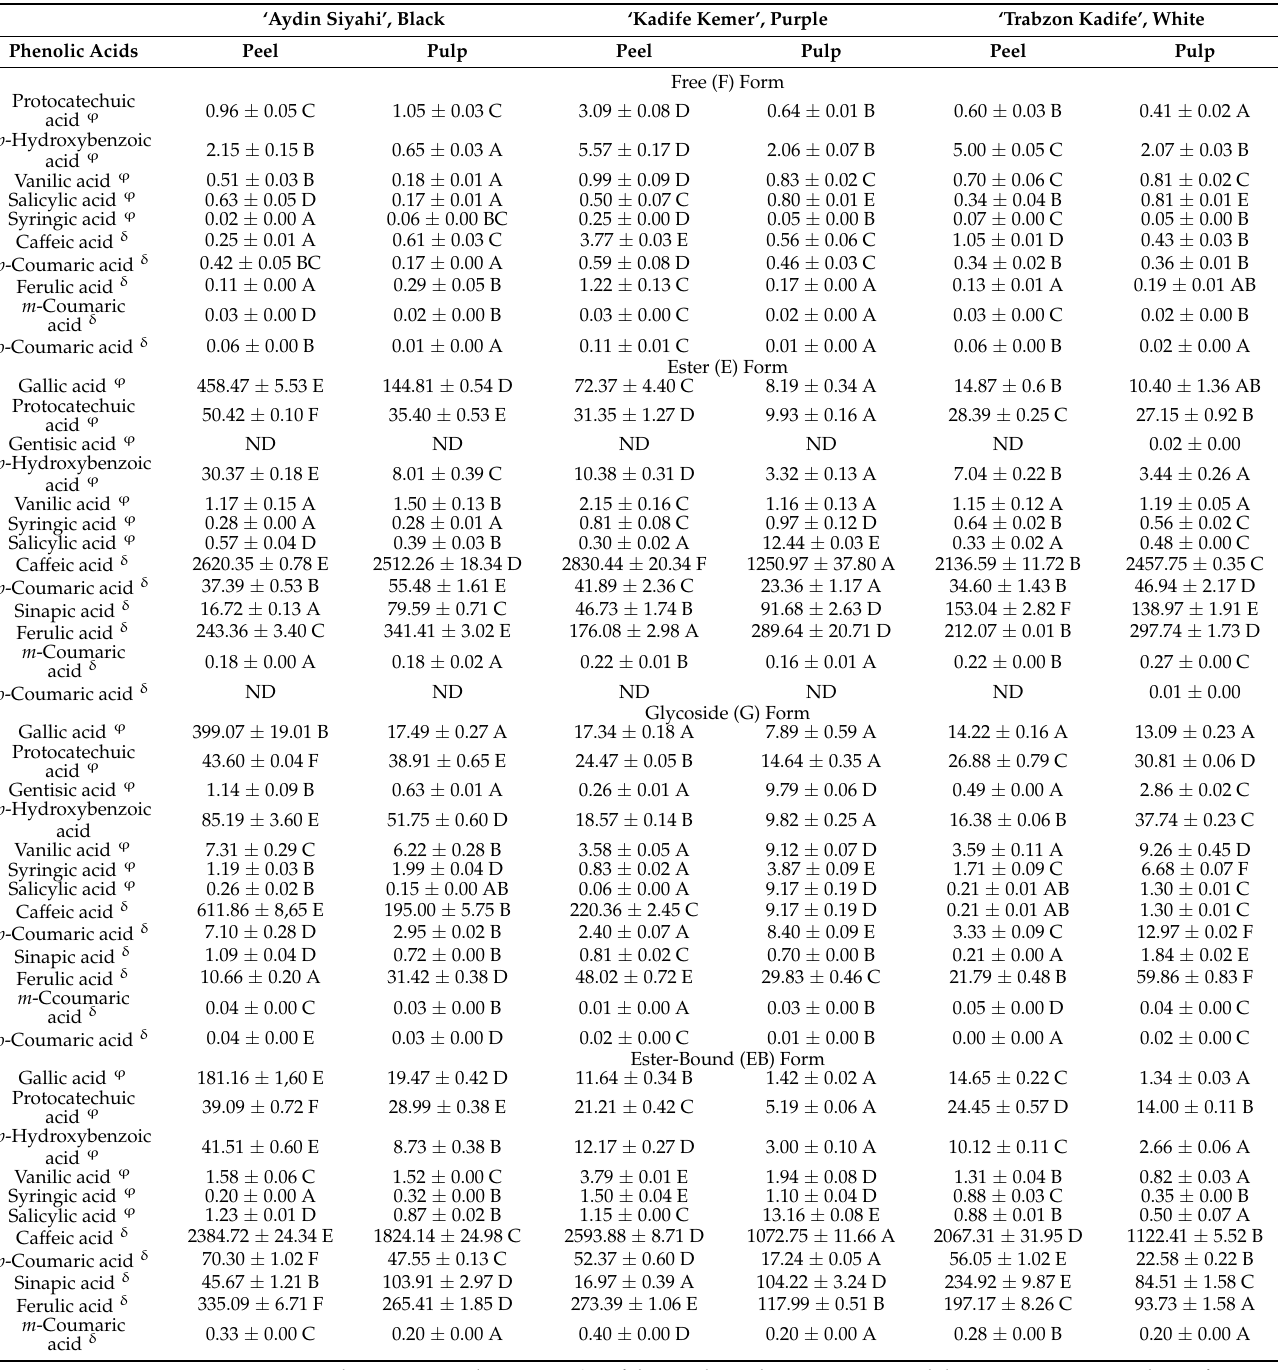
Table 2. Phenolic acid contents (mg/kg fresh weight) in the fruits of common eggplants *. ‘Aydin Siyahi’, Black ‘Kadife Kemer’, Purple ‘Trabzon Kadife’, White Phenolic Acids Peel Pulp Peel Pulp Peel Pulp Free (F) Form